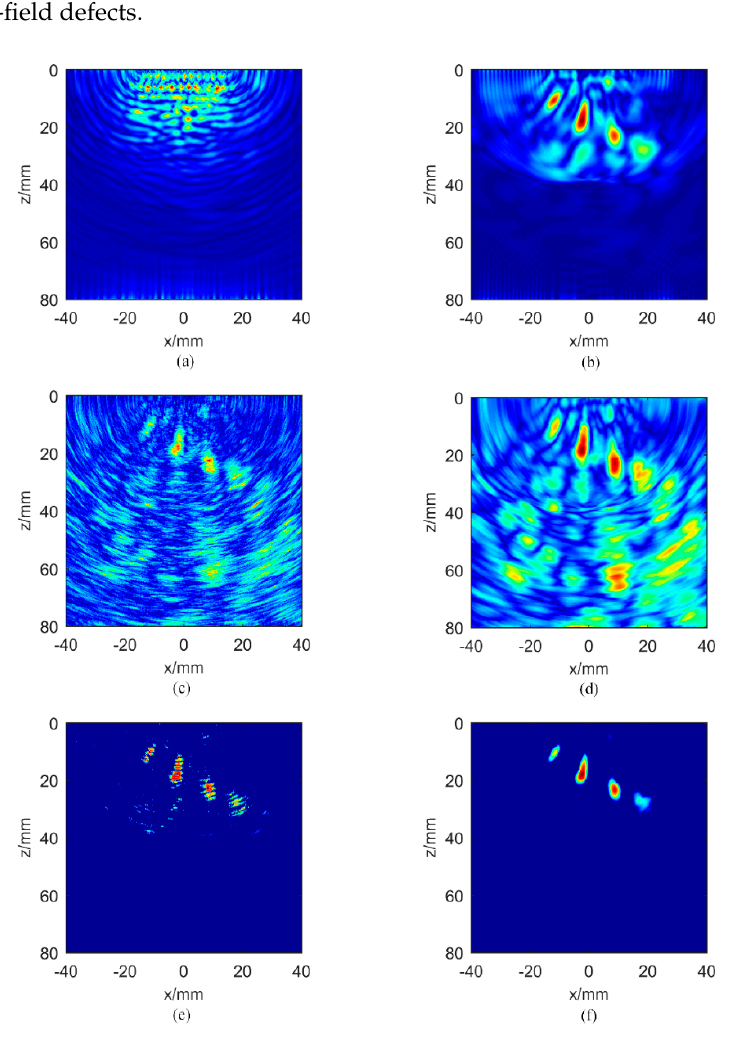
Figure 5. Images of aluminum plate A: amplitude total focusing method (TFM) images for ( a ) the direct full matrix and ( b ) the hybrid full matrix; instantaneous phased coherence weighting factor for ( c ) instantaneous phase weighting factor (IPWF) and ( d ) instantaneous phase coherence factor (IPCF), σ = 1; amplitude images multiplied by ( e ) IPWF and ( f ) IPCF, σ = 1.